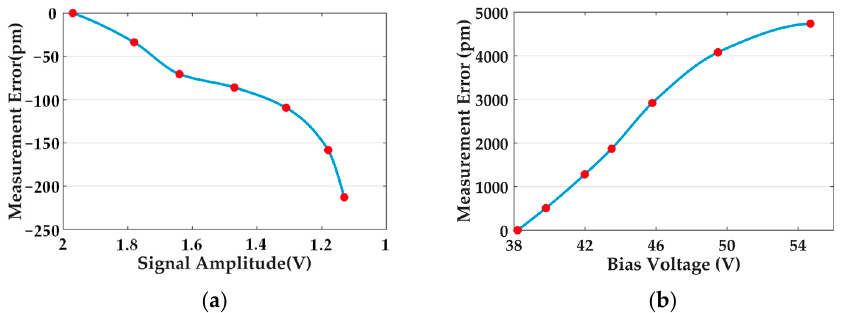
Figure 8. Fitting curves of experiment results for displacement error compensation using ( a ) best-gain detection method and ( b ) auto-gain detection method.